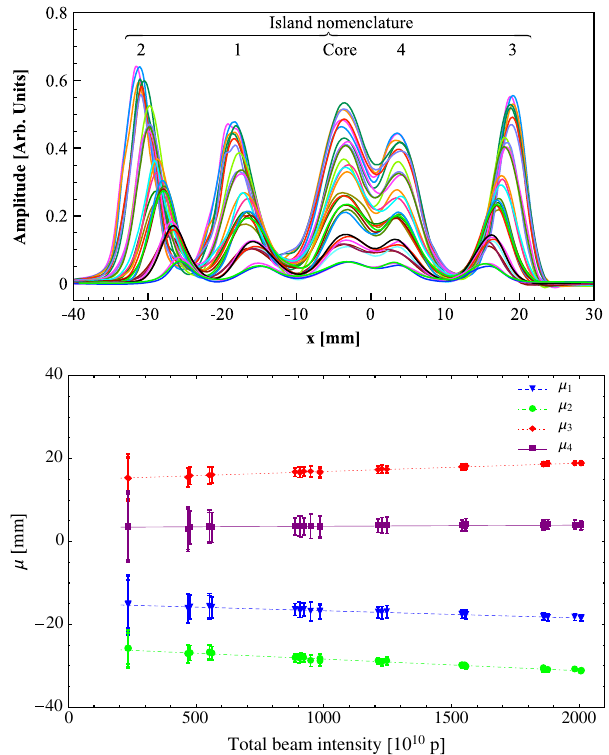
FIG. 1. Summary of the experimental results of intensity- dependent effects with split beams from [13]. Upper: horizontal beam profiles measured with a wire scanner at the end of the splitting process with different total beam intensities. Lower: position of the peaks of the beamlets after splitting as a function of the total beam